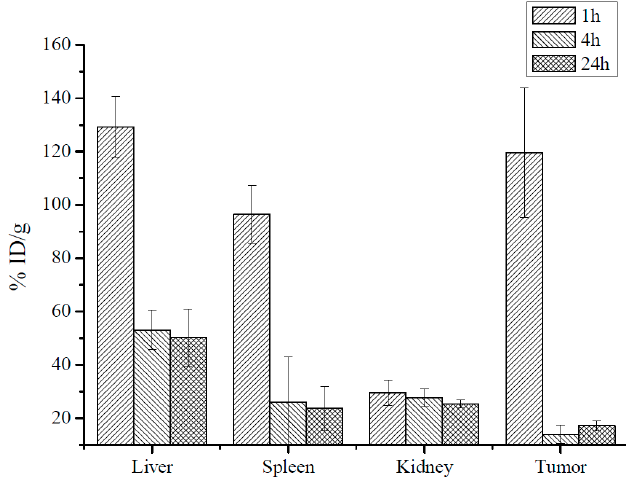
Figure 3. MNP iron oxide core biodistribution after MNP-HSA@PS i.v. injection.